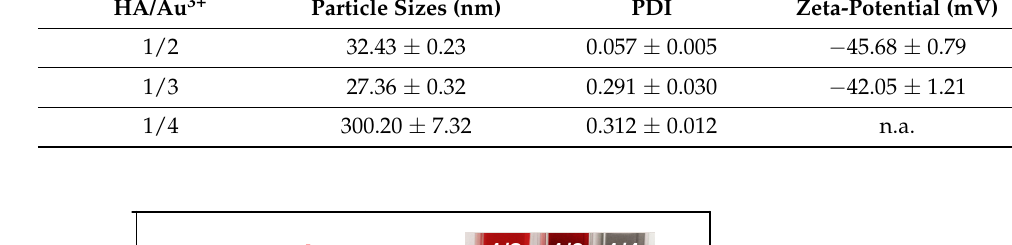
Table 1. Average particle size, PDI value and zeta potentials of different HA-reduced AuNPs. HA/Au 3+